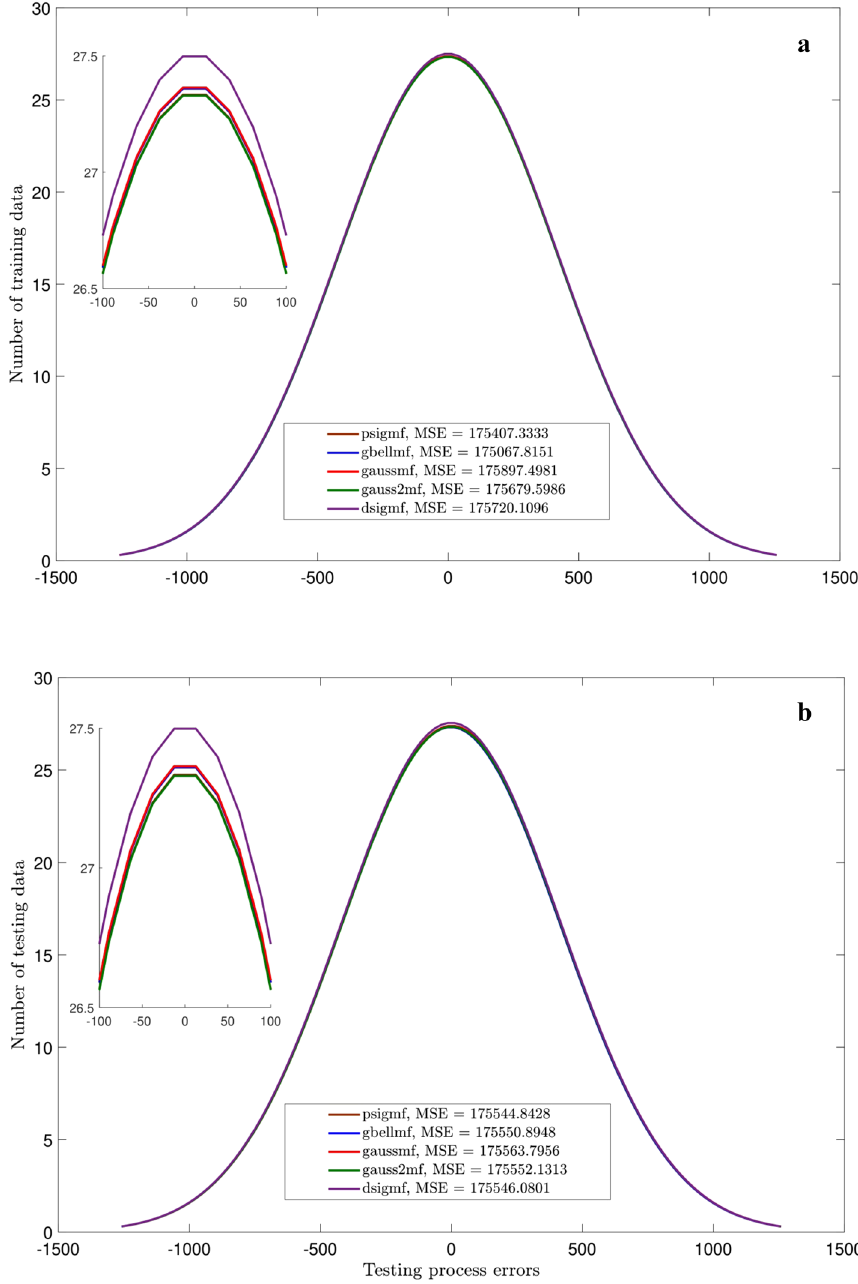
Figure 3. ( a ) Errors of training for different MF. Number of inputs = 2. ( b ) Errors of testing for different MF. Number of inputs =